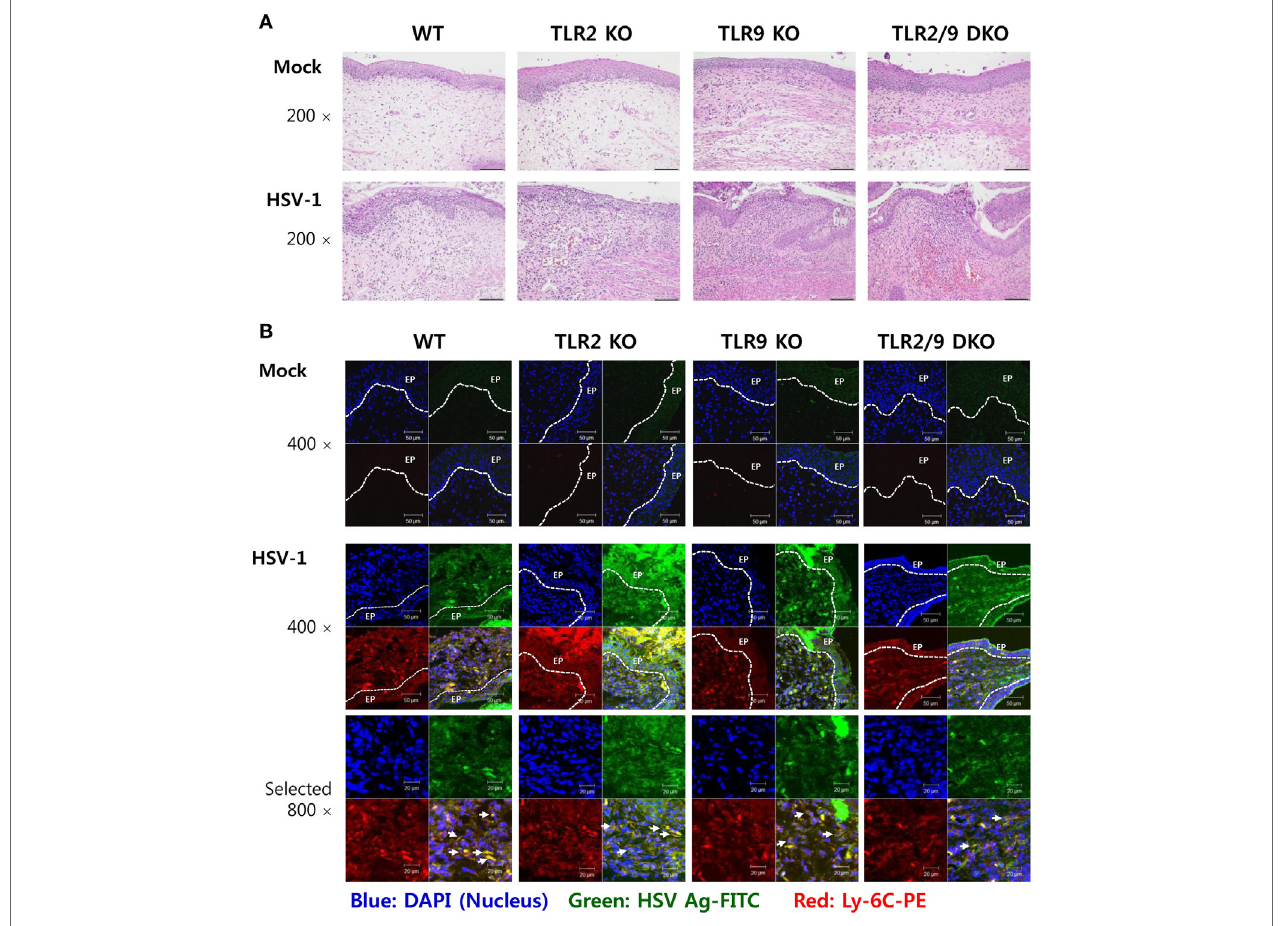
FigUre 3 | Histopathological examination and confocal microscopy confirm the early accumulation of Ly-6C + monocytes in vaginal tissues following herpes simplex virus (HSV)-1 infection. (a) Representative photomicrographs of vaginal tissue sections stained with H&E. Photomicrographs were taken from submucosal and epithelial areas 2 days after mucosal HSV-1 infection (1 × 10 7 pfu/mouse). Images are representative of sections (200 × ) from at least four mice. (B) Confocal microscopy of vaginal tissues. Sections of vaginal tissues obtained from HSV-infected wild-type (WT) (C57BL/6), TLR2 KO, TLR9 KO, and TLR2/9 double knock-out (TLR2/9 DKO) mice were co-stained for HSV Ag (gB) (green), the nuclear stain DAPI (blue), and the monocyte marker Ly-6C (red) 2 days post-infection. Images are representative of sections (400 × ) from at least four mice, and the lower image is a selected area magnified by twofold (800 × ). Some Ly-6C + monocytes co-localized with HSV Ag are denoted by white arrows. White dot-line shows epithelial layer (EP layer). Sections of vaginal tissues obtained from uninfected mice were used for negative control